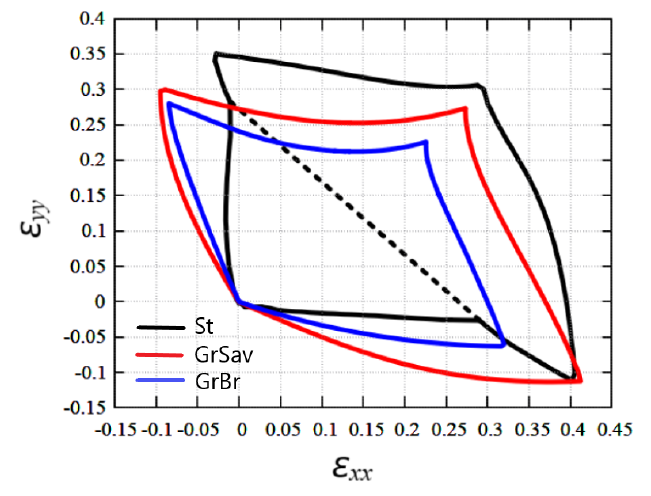
Figure 6. Comparison of stability regions of planar stanene (St, black line) and graphene obtained using Savin’s potential [49] (GrSav, red line) and Brenner’s potential (GrBr, blue line)